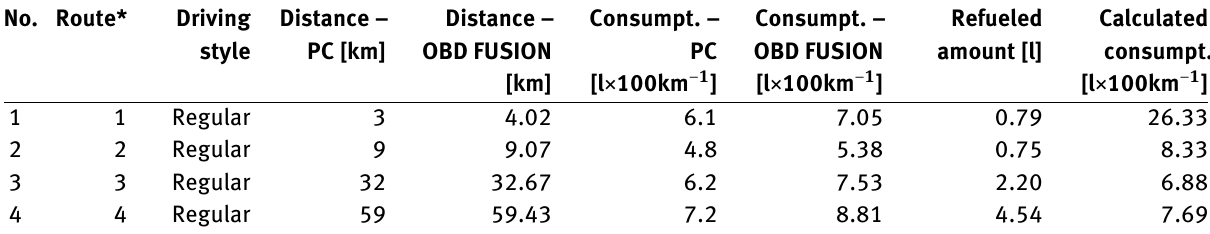
Table 7: Results of the second investigation of fuel consumption related to compression ignition engine No.